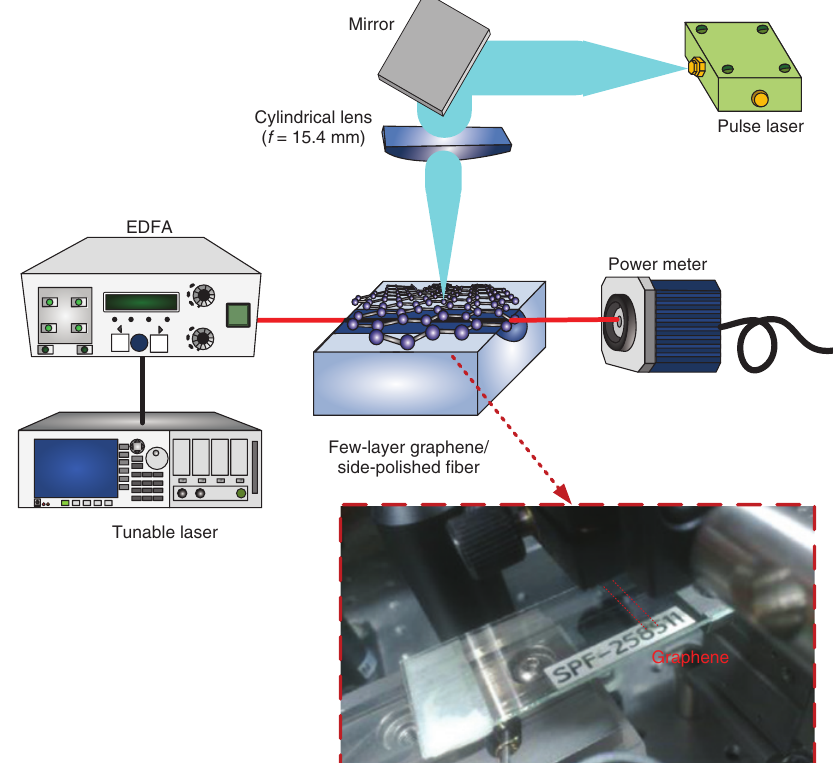
Figure 2: Schematic diagram of measuring system for analyzing the all-optical switching effect of the few-layer graphene side-polished